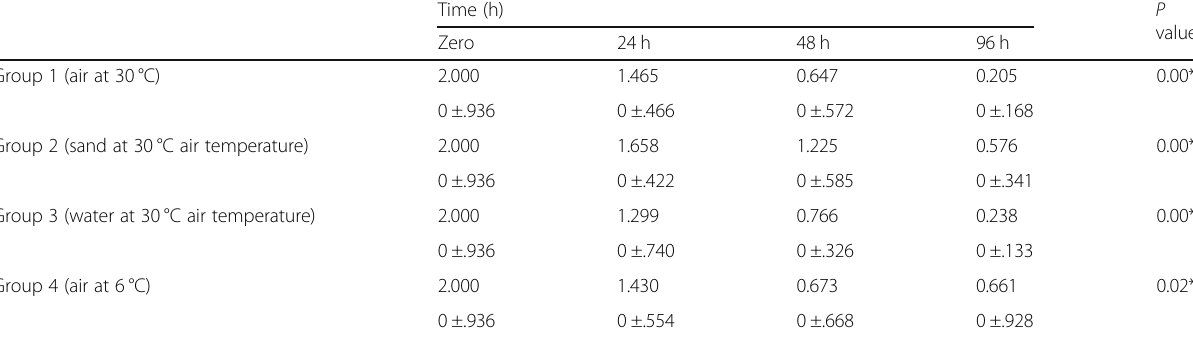
Table 3 Comparison of the mean heart GAPDH levels at different postmortem time points in the studied groups